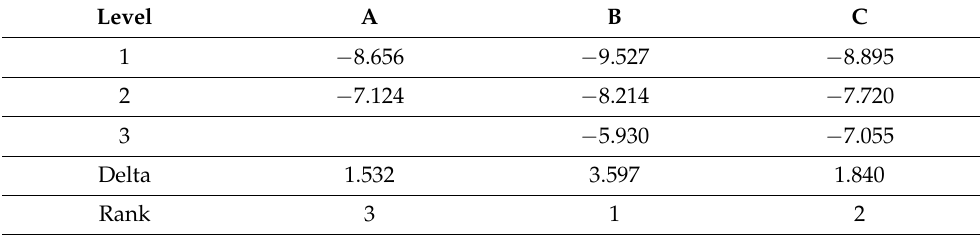
Table 6. Response table for signal to noise ratios for productivity (larger is better).